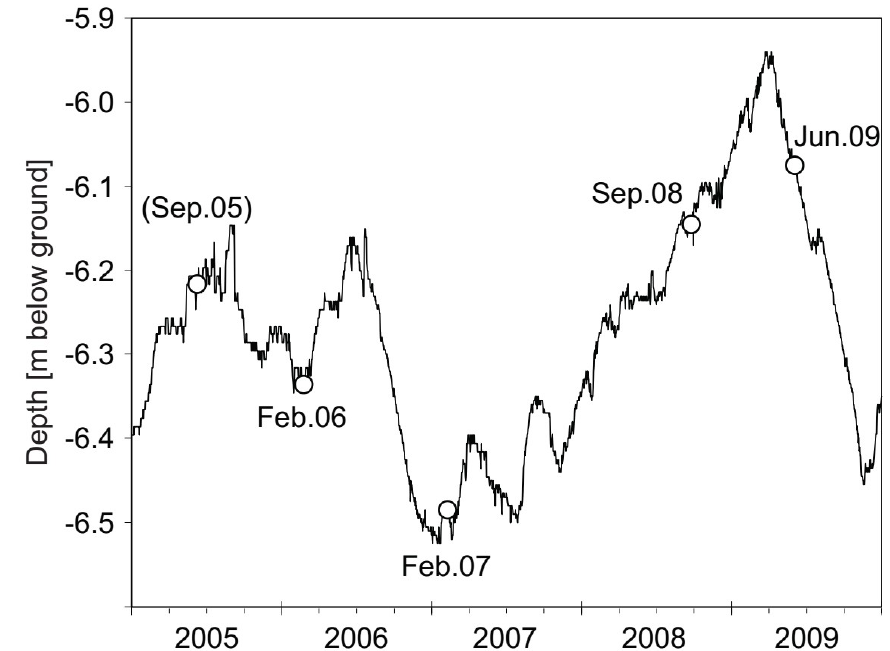
Figure 1. Fluctuation of the groundwater table over the period of investigation. Measurements were performed using water table logging in the conventional monitoring wells 19179 and 19223 (Figure S1) adjacent to the high-resolution multi-level well (HR-MLW) used for high-resolution water and sediment sampling. Circles indicate the four time points of sediment and groundwater sampling, and one time point of groundwater sampling only (February 2007). Field data from September 2005 have been previously reported [12] .